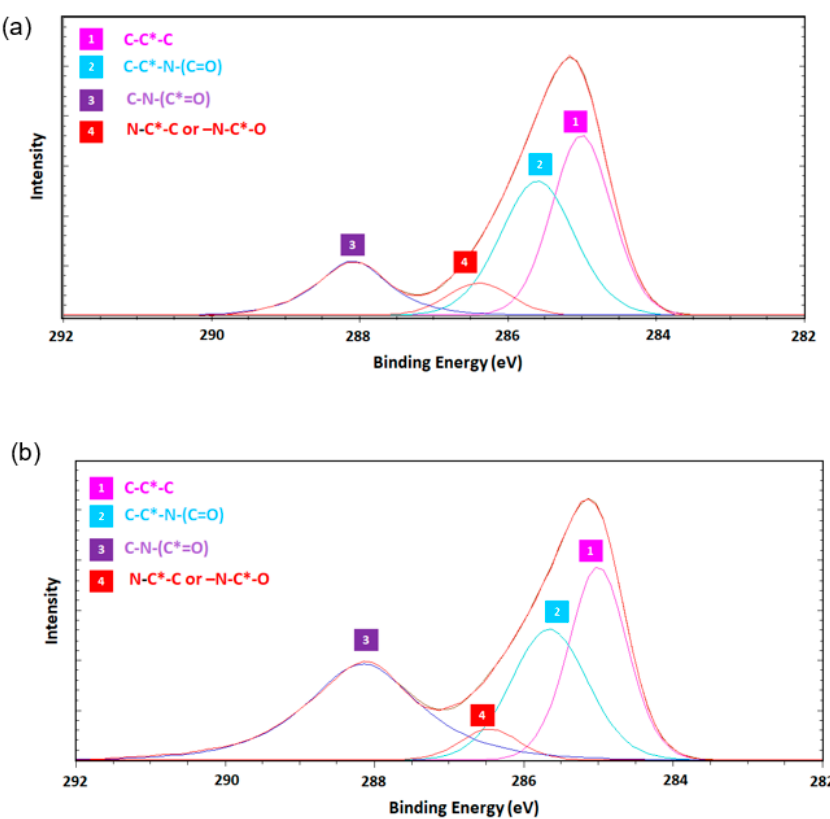
Figure 12. Deconvoluted high-resolution C1s spectra of ( a ) untreated and ( b ) He/H 2 O plasma-treated nylon surfaces.